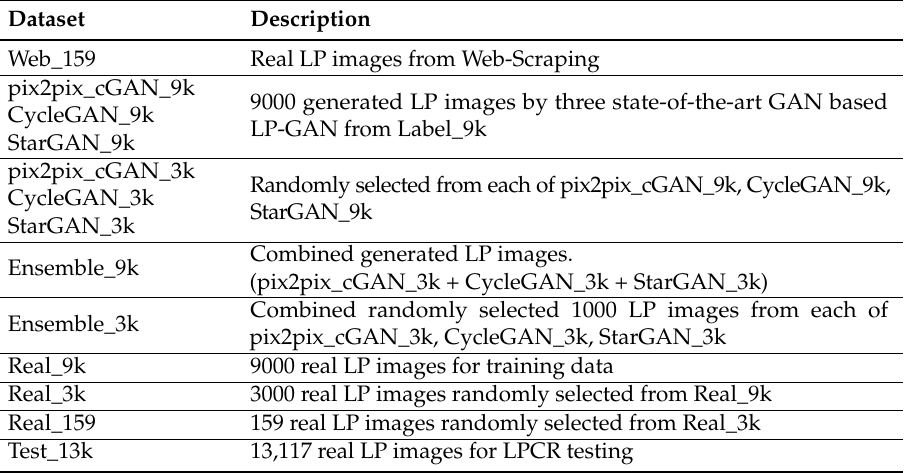
Table 3. 13 datasets for